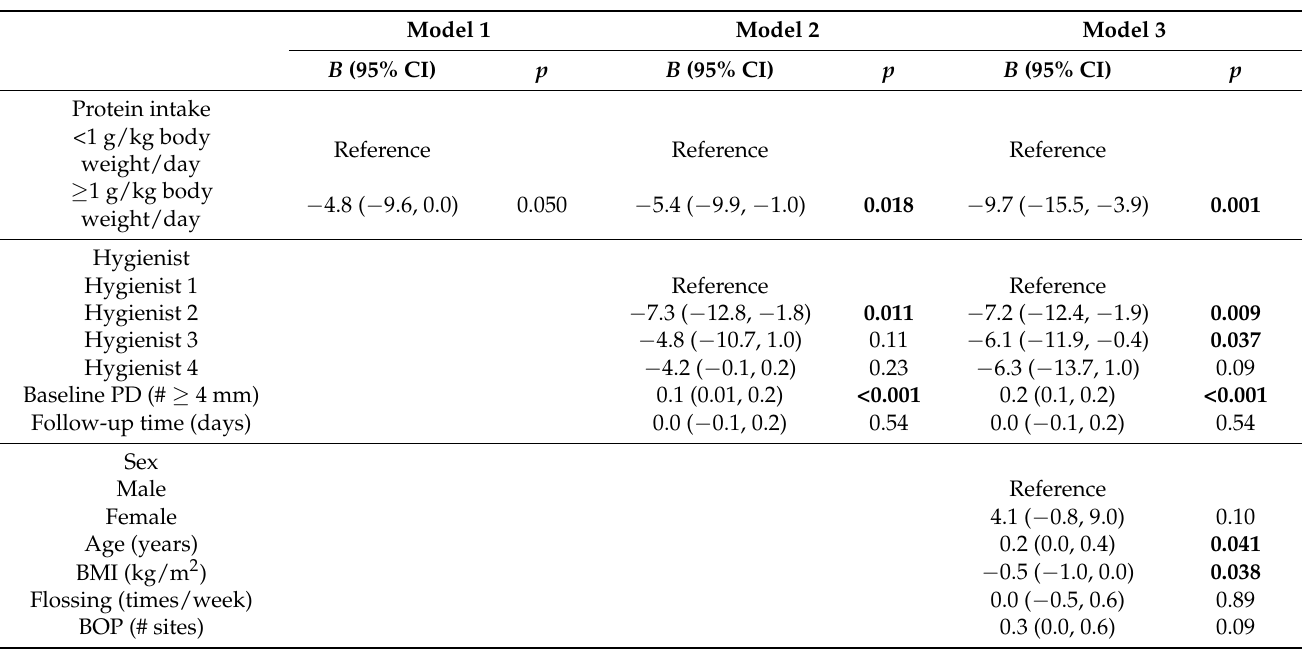
Table 2. Multiple linear regression of probing depth sites > 4 mm in patients after non-surgical periodontal therapy who did not smoke 1 .